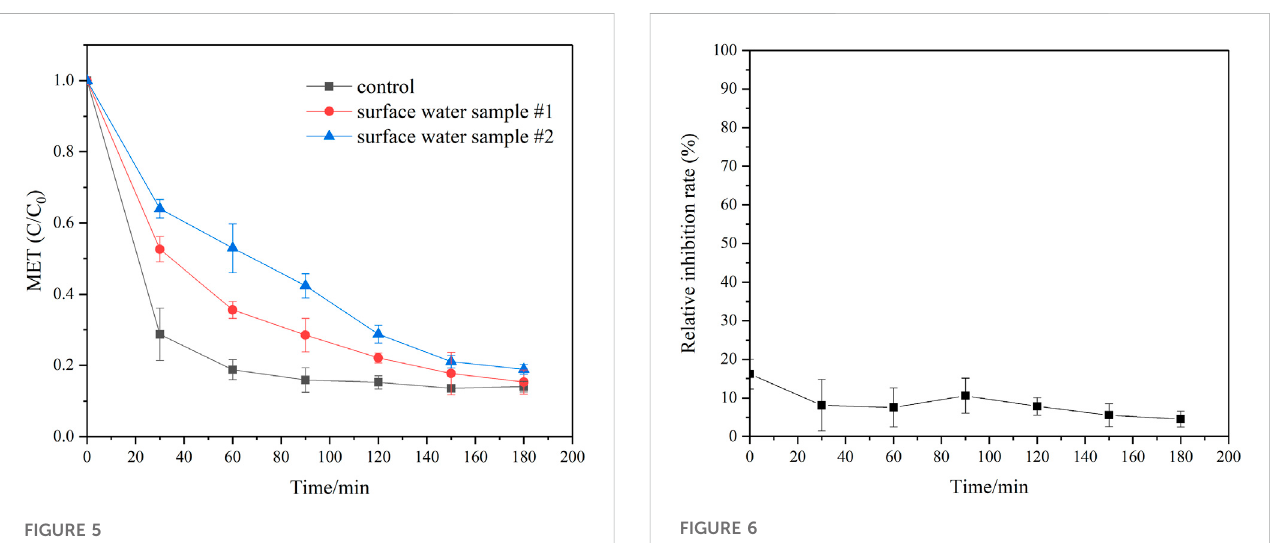
FIGURE 5 MET degradation in the real water matrix. Experimental conditions: [MET] 0 = 2.5 mg/L, [Sul fi te] 0 = 10 mM, UV intensity = 100% I 0 .